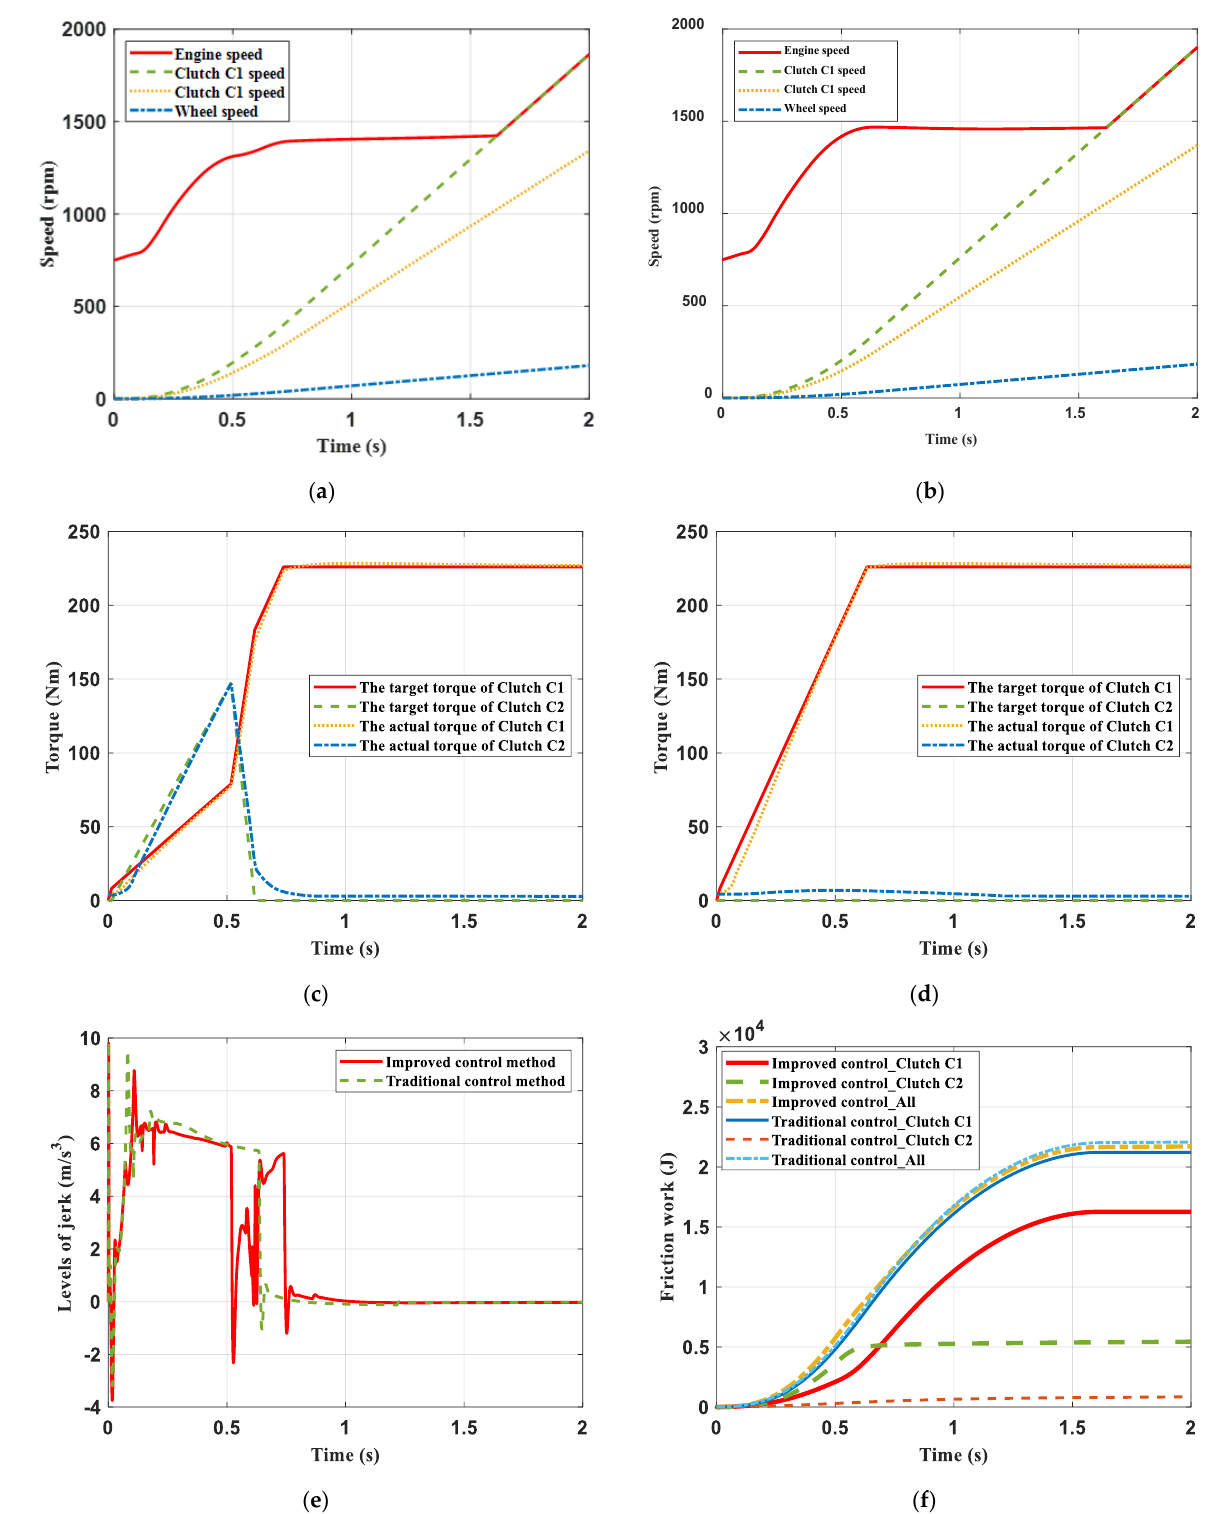
Figure 9. The simulation results of slowly starting of the traditional control strategy and the proposed control strategy. ( a ) The speed of main components with the improved control strategy; ( b ) The speed of main components with the traditional control strategy; ( c ) The target and actual torque